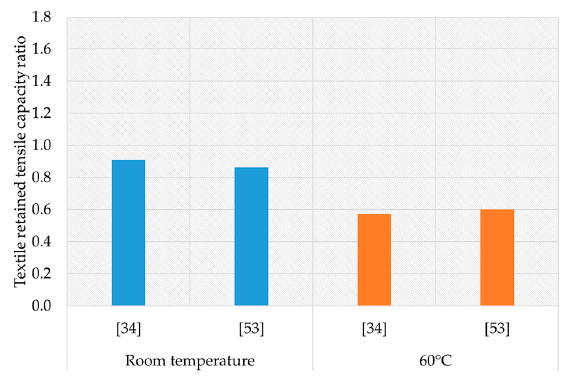
Figure 6. Retained tensile capacity ratio of AR-glass immersed in seawater (blue bin = room temperature and orange bin = temperature equal to 60 °C).